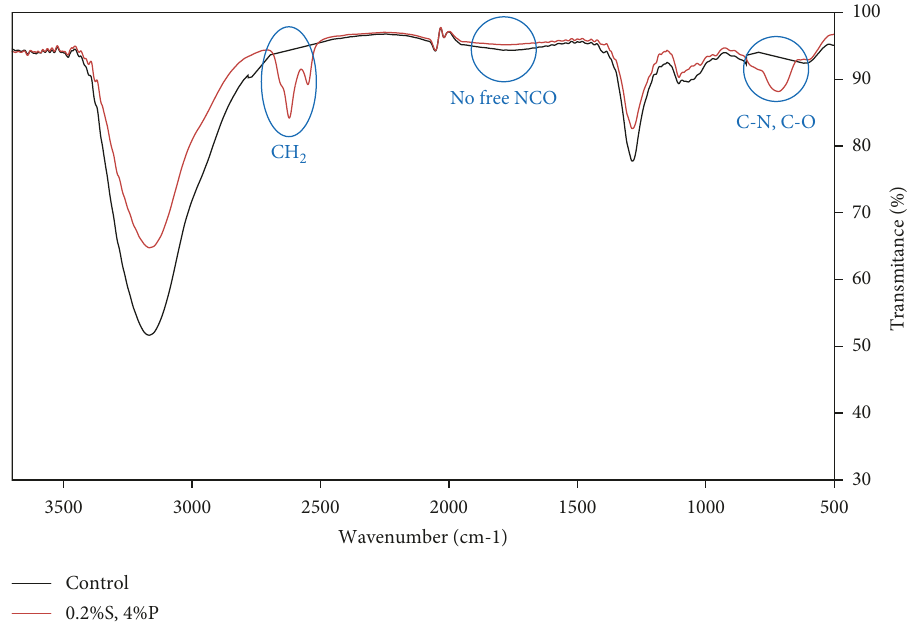
Figure 10: FTIR spectra of base and modified